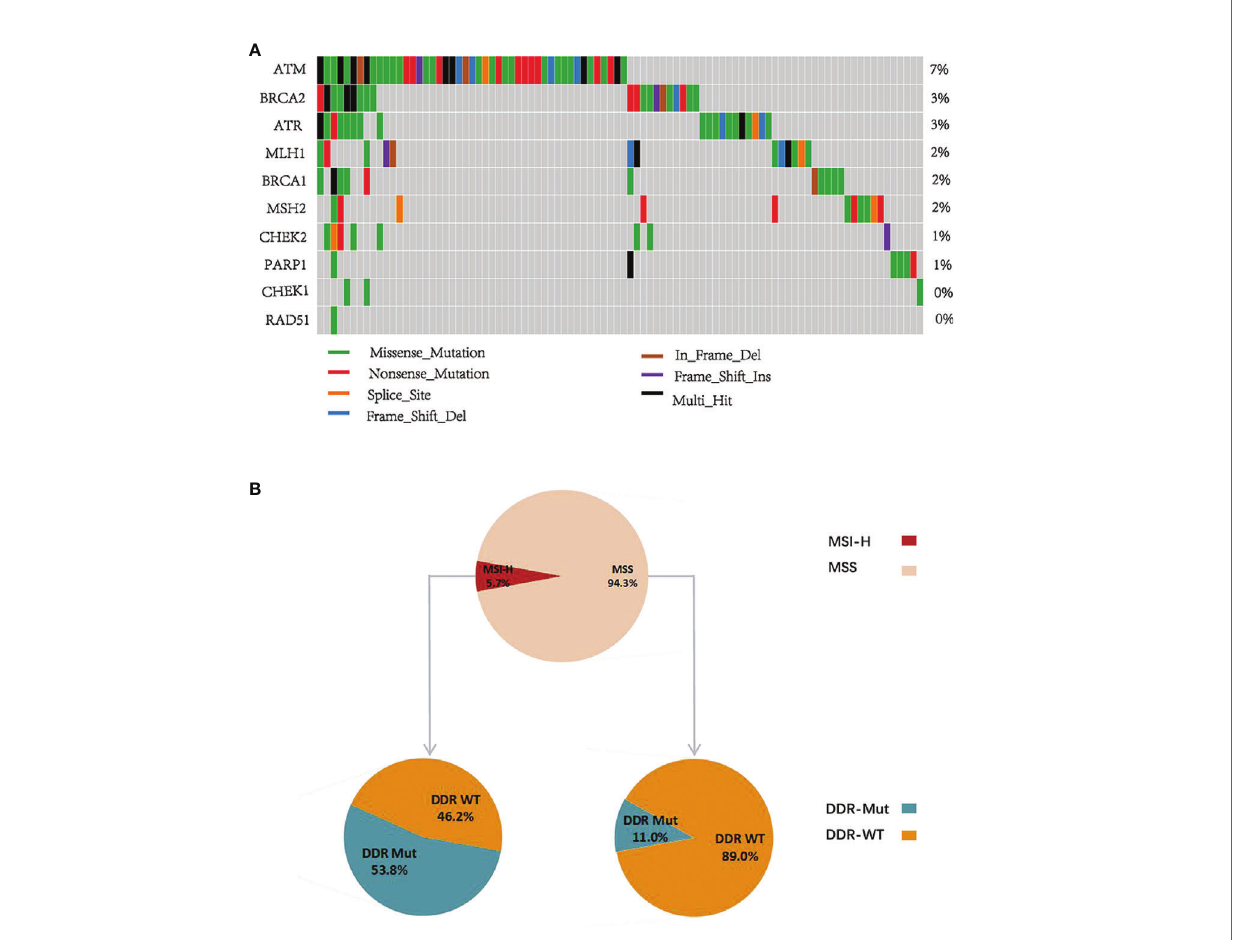
FIGURE 5 | DNA damage repair (DDR) gene mutational pattern in a Chinese colorectal cancer (CRC) cohort. (A) The mutation frequency of 10 DDR genes in Chinese CRC patients. (B) The proportion of DDR Mut and DDR WT in the microsatellite instability-high (MSI-H) and microsatellite stable (MSS)